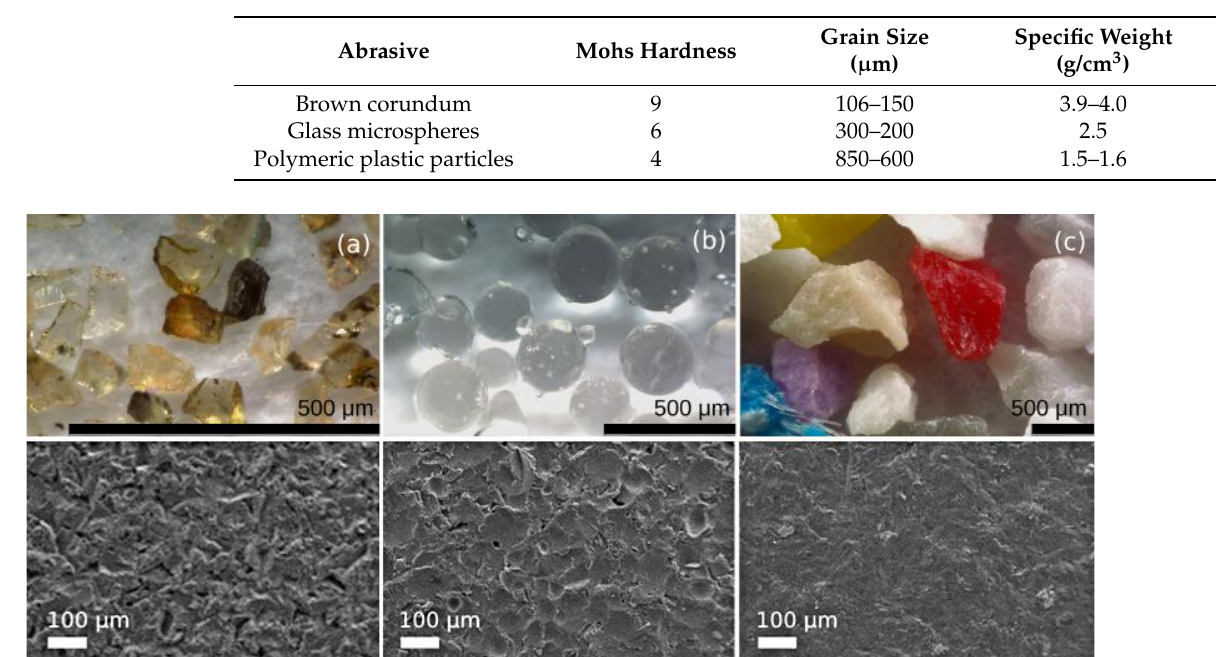
Figure 3. Morphology of the abrasives by Leica DVM6 confocal microscope: ( a ) Brown corundum, ( b ) glass microspheres, ( c ) polymeric-plastic particles, and SEM images of sandblasted aluminum substrates.